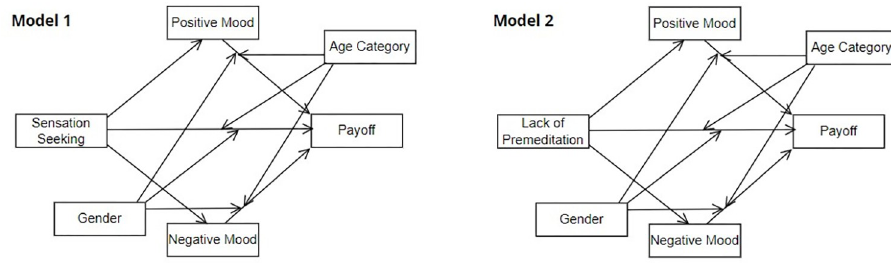
Fig 2. Mediation-moderation models 1 and